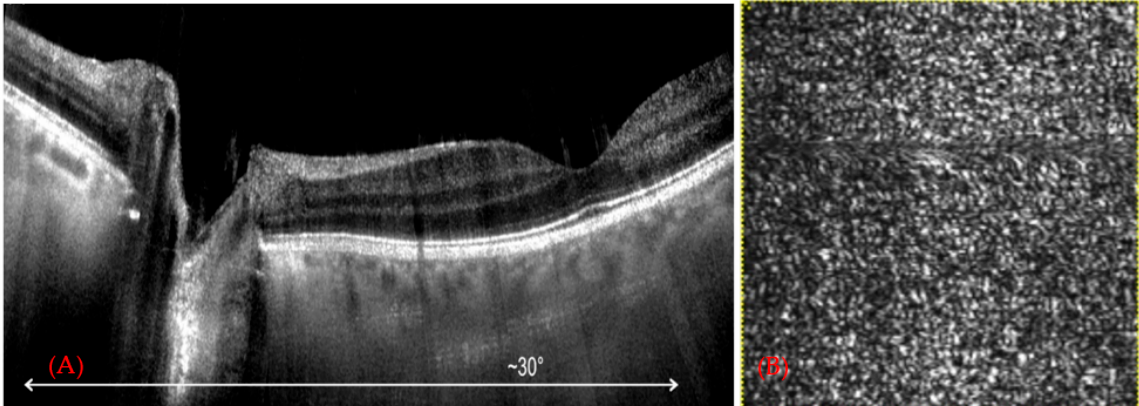
Figure 11. Reproduced with permission from Ref. [112]. ( A ) Averaged stitched widefield in vivo B-scan image of the retina, choroid and optical nerve head. ( B ) High lateral resolution en-face image of cone cells in the retina.